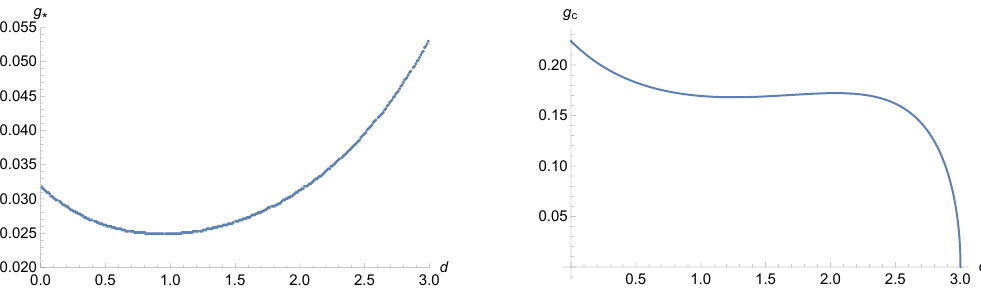
Figure 14. Plots of g ? and g c as functions of d . The two curves cross at d ’ 2 :